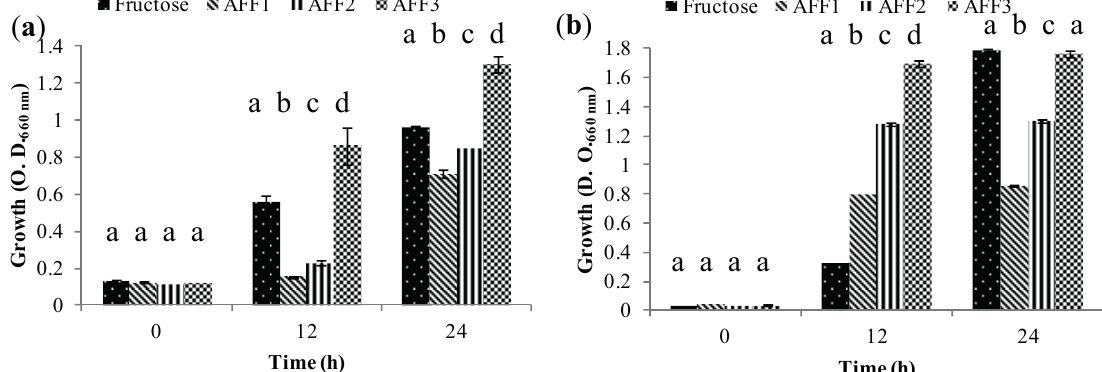
Figure 6. Growth (O.D.) of probiotic bacteria in Group 3 (G3) at 0, 12 and 24 h in semi-synthetic medium using AFF1, AFF2, AFF3 as the sole carbon source and fructose as fermentation control. ( a ) Bifidobacterium adolecentis ATCC 15703. ( b ) Bifidobacterium infantis ATCC 17930.